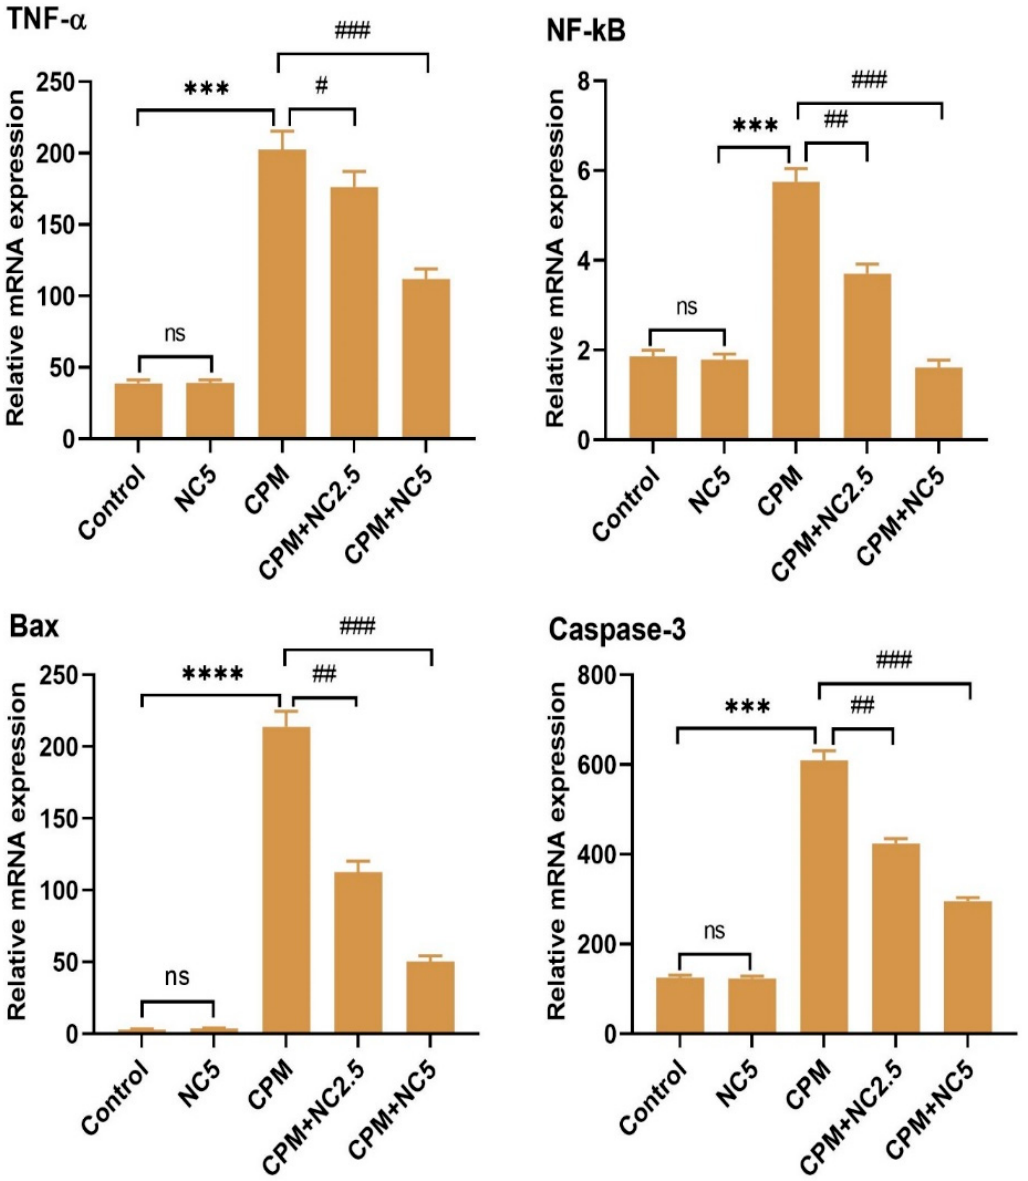
Figure 4. Representation of effect of NC against CPM treatment on mRNA transcription level of TNF- α , NF-kB, Bax and caspase 3. Values signify the mean ± SE (n = 3) of samples. **** p < 0.0001; *** p < 0.001 vs. control, # p < 0.05; ## p < 0.01; ### p < 0.001 vs. CPM, ns = non-significant.